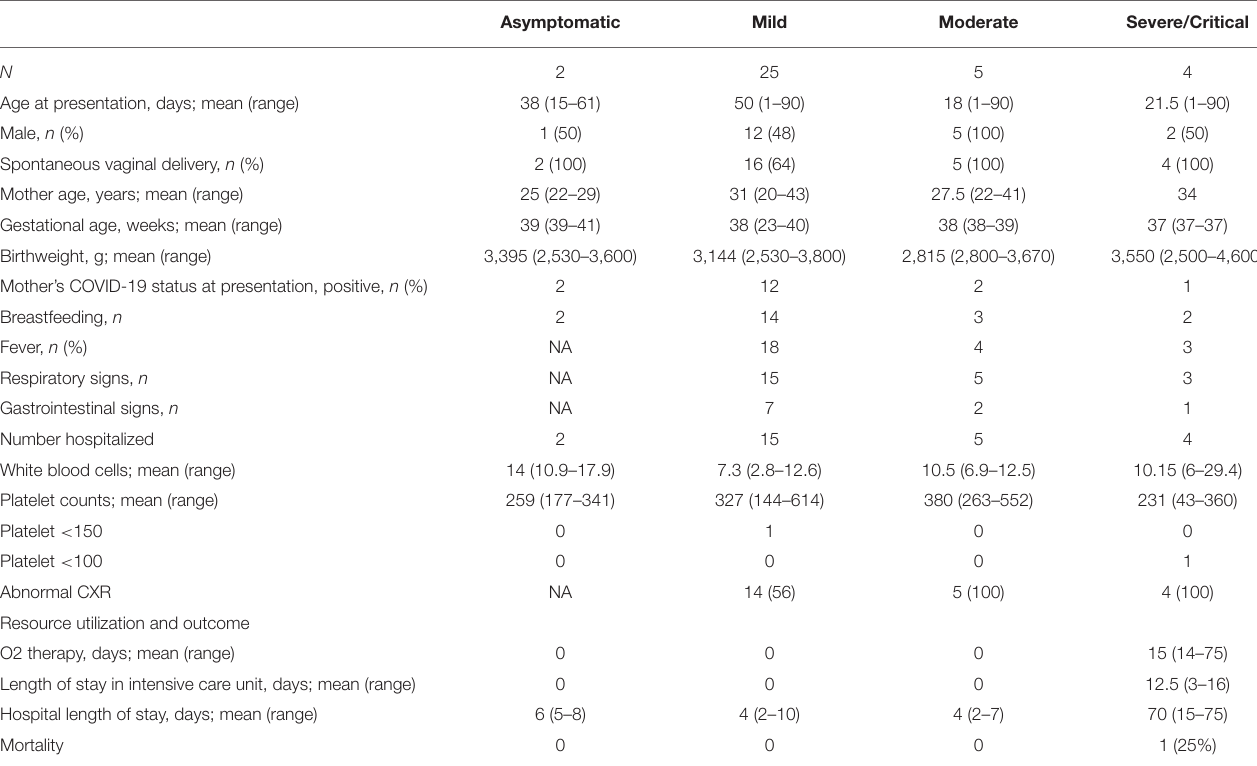
TABLE 1 | Clinical and laboratory characteristics of COVID-19 in early infancy. Asymptomatic Mild Moderate